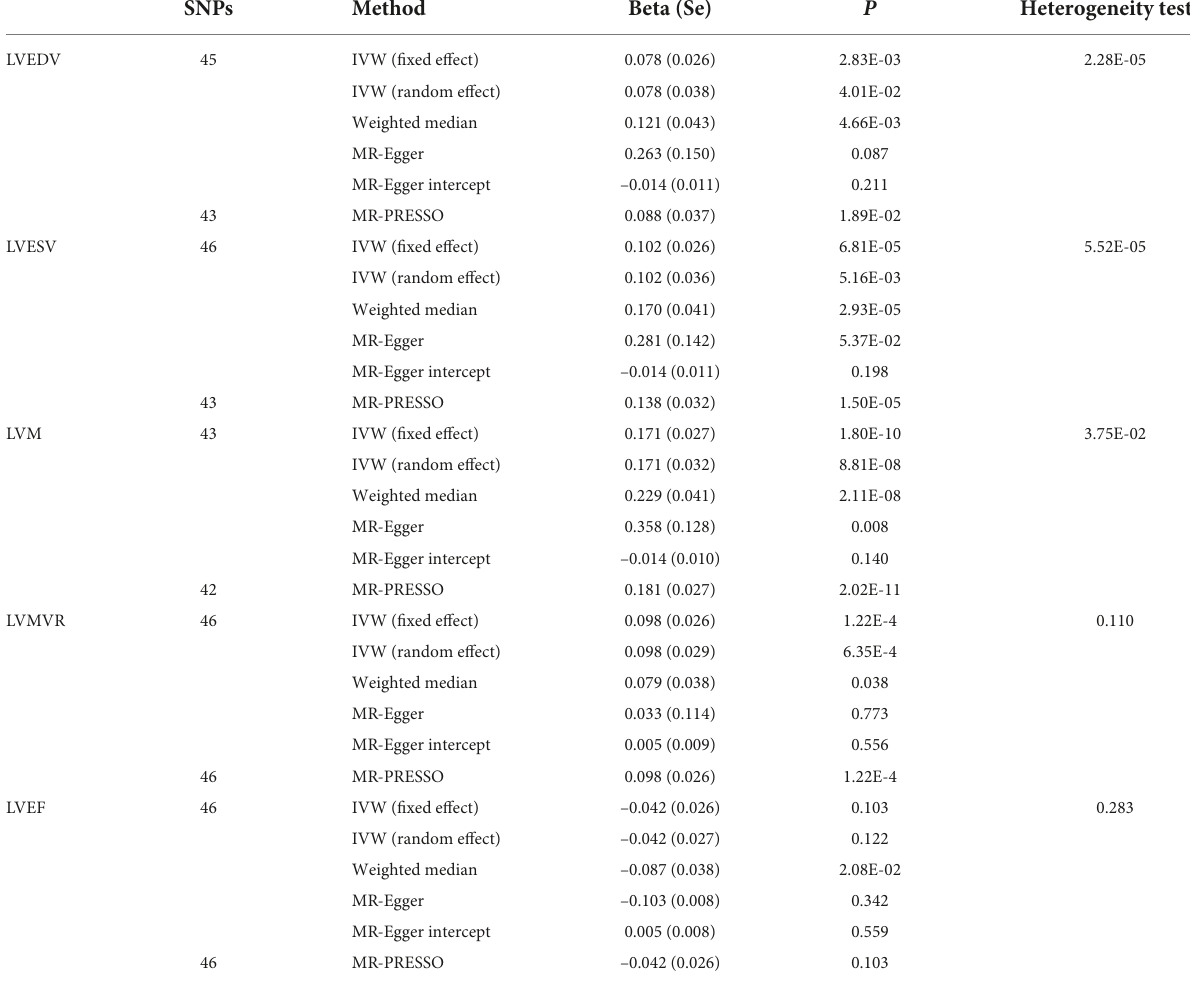
TABLE 2 Effect size of hypertension and LV with different MR